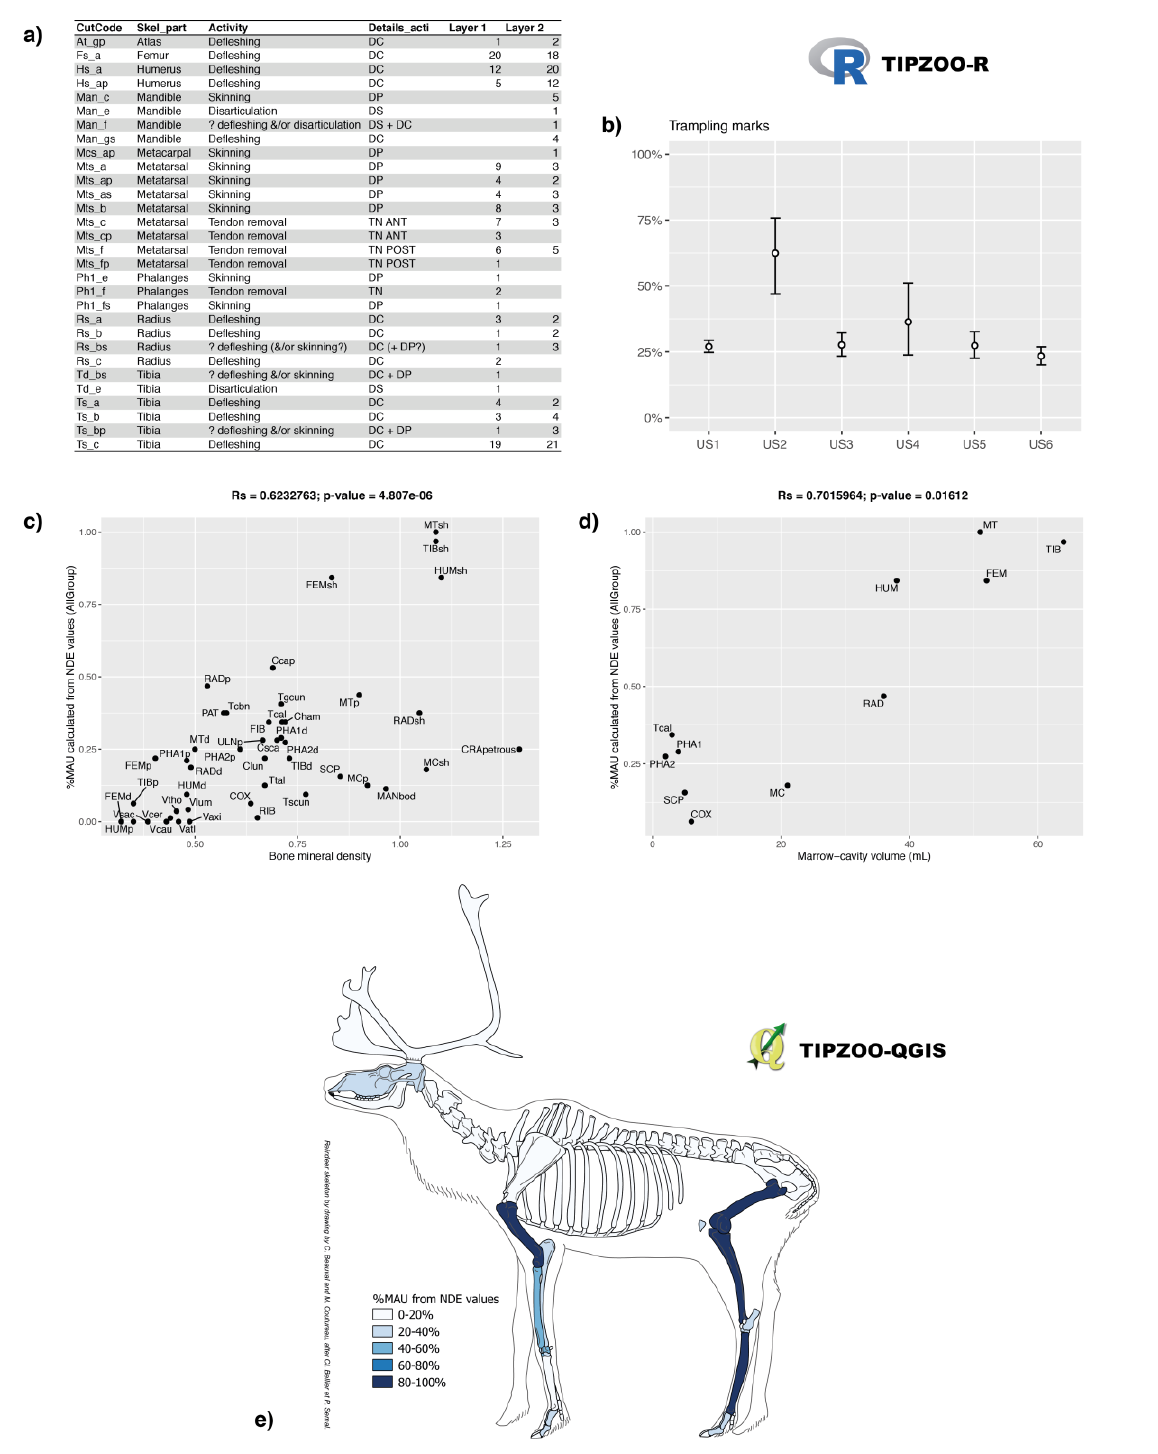
Figure 3 . Examples of TIPZOO-R (a-d) and TIPZOO-QGIS (e) outputs. These tables and graphs are easily produced by running the different TIPZOO tools. a) Preformatted table listing the cut mark codes and activities identified in different layers; b) Percentage of bones with trampling marks across 6 different field layers with 95% confidence intervals; c) Analysis of density-mediated bone destruction, with biplot and Spearman correlation test; d) Utility-based analysis of bone differential transport using marrow- cavity volumes, with biplot and Spearman correlation test; e) Skeletal-part representation of reindeer bones in %MAU automatically calculated from NDE landmark